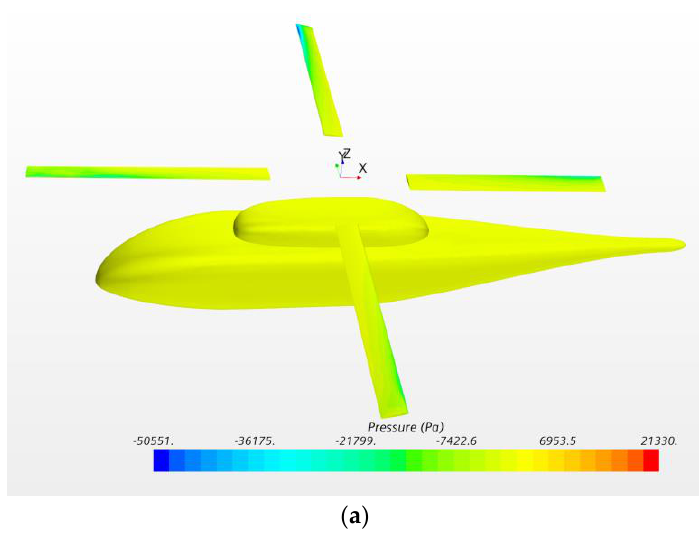
Figure 10. Velocity contours of Robin fuselage/rotor interference flow field. ( a ) μ = 0.151. ( b ) μ = 0.231.